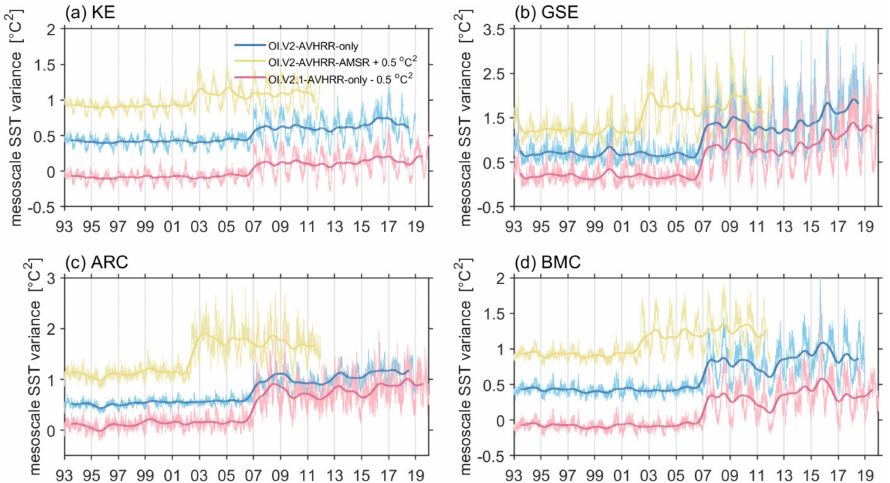
Figure 3. Time series of the mesoscale SST variance in the ( a ) KE, ( b ) GSE, ( c ) ARC, and ( d ) BMC regions. The blue, yellow, and red lines denote the values based on the OI.V2-AVHRR-only data, OI.v2-AVHRR-AMSR data, and OI.v2.1-AVHRR-only data, respectively. For comparison, the yellow (red) line is the original value plus (minus) 0.5 ◦ C 2 . The thin and thick lines denote the daily and 1.5-year low-pass filtered time series, respectively.